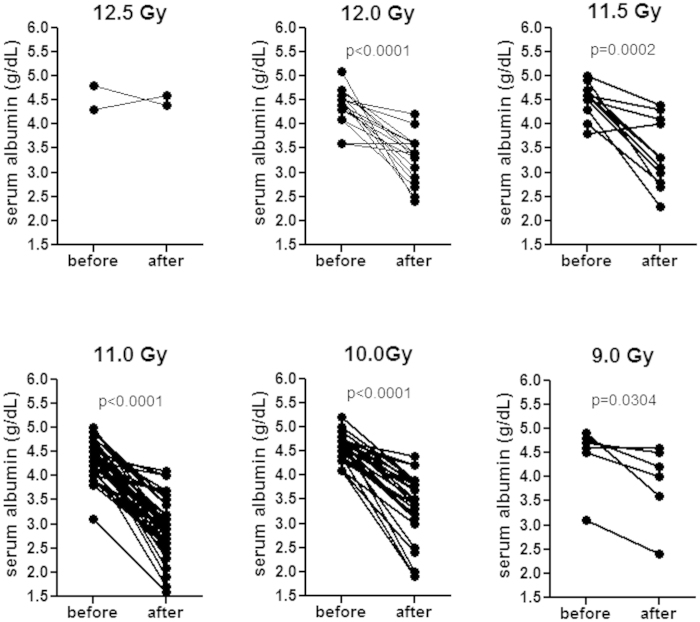
Paired comparisons of serum albumin levels of NHP before and after PBI/BM5.The albumin level after PBI/BM5 is the albumin level on the day of euthanasia or the most recent value if no assay were performed on that day. Note that not all NHP had serum albumin levels measured. Paired comparison of serum albumin levels was performed in each dose cohort. 12.5 Gy (n = 2), 12.0 Gy (n = 17), 11.5 Gy (n = 12), 11.0 Gy (n = 40), 10.0 Gy (n = 27), 9.0 Gy (n = 6). The p value cannot be calculated for the 12.5 Gy because it only had two pairs of data. All other dose cohorts have significantly lower albumin level after PBI/BM5 compared to the baseline level.